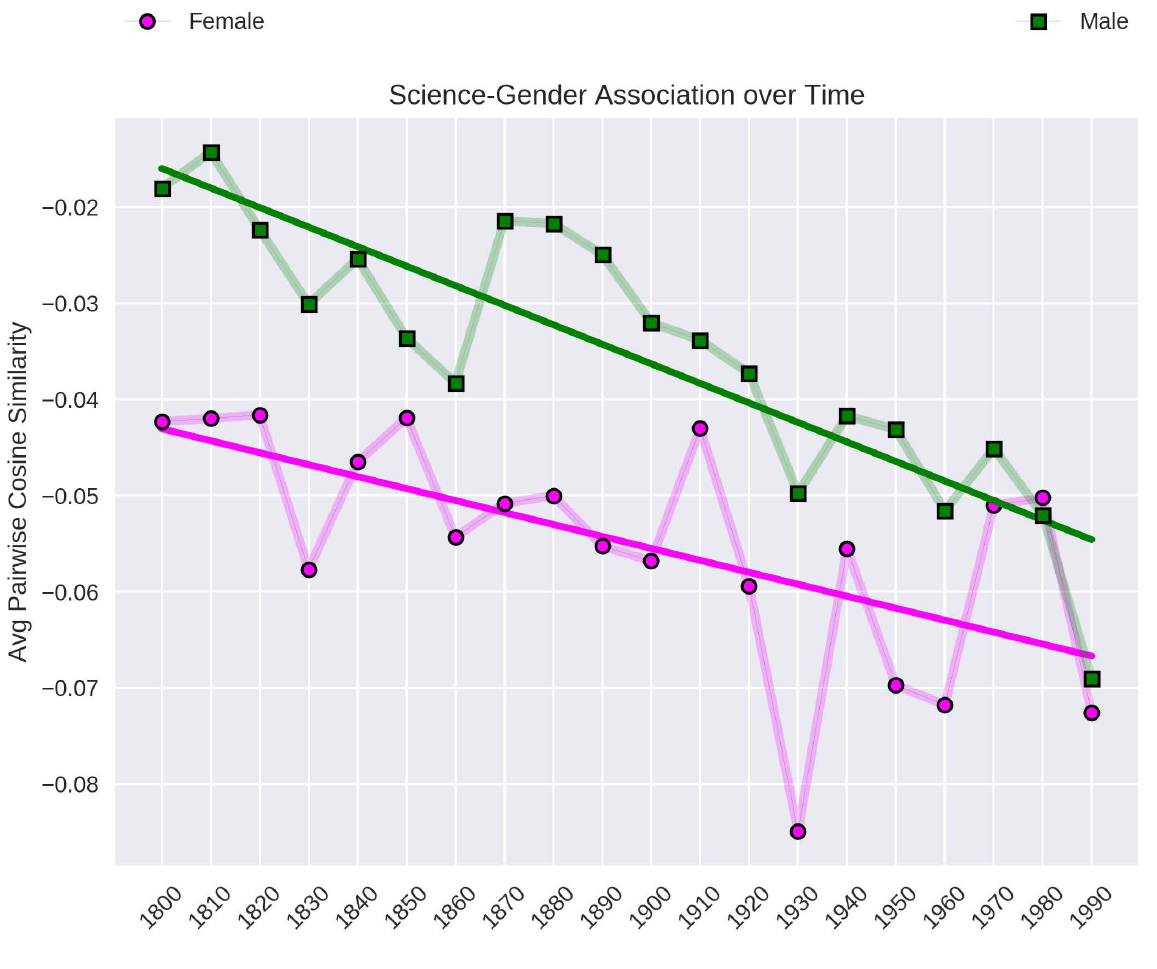
Figure 5: Female association and male association with the Science domain measured by decade. The x axis is labeled with the first year of each decade (e.g., the label “1910” is used to mark the measurement based on the word embedding trained on text from 1910 up to but not including 1920). Avg,